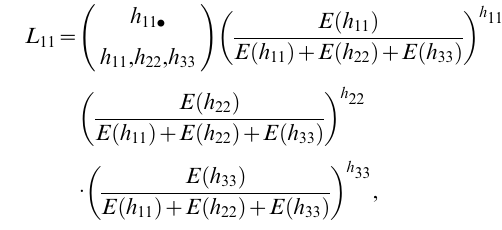
Fourteen different demographic scenarios were simulated 10,000 times each, with population abundance reconstructed over a 24-year period, using both the full age-class and pooled adult age-class information (Table 1). The relative bias for the full